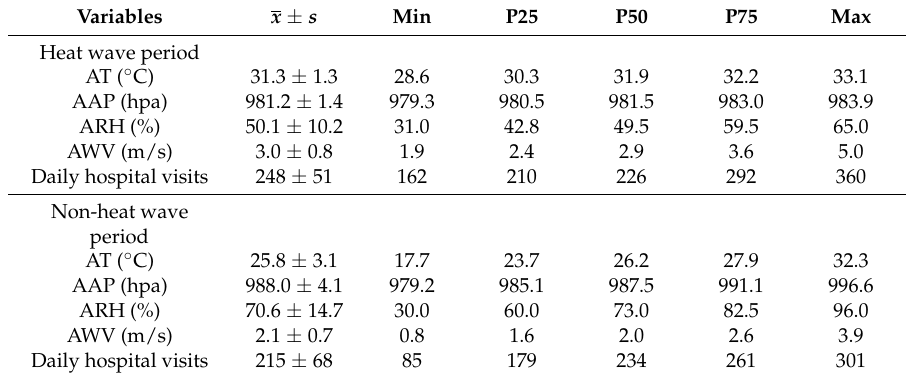
Table 4. Description of daily hospitalized cases during the study period according to ICD-10.